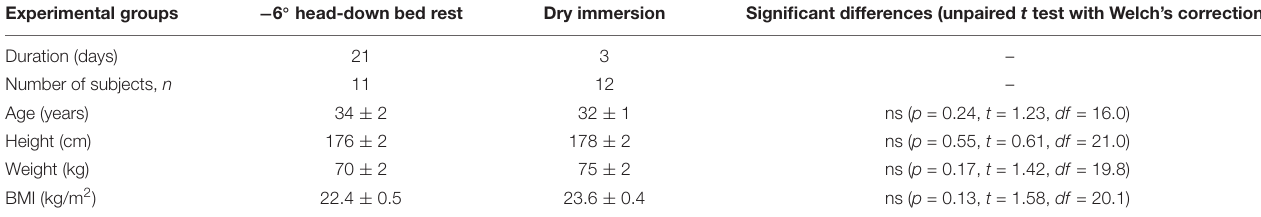
TABLE 1 | Comparative data of two